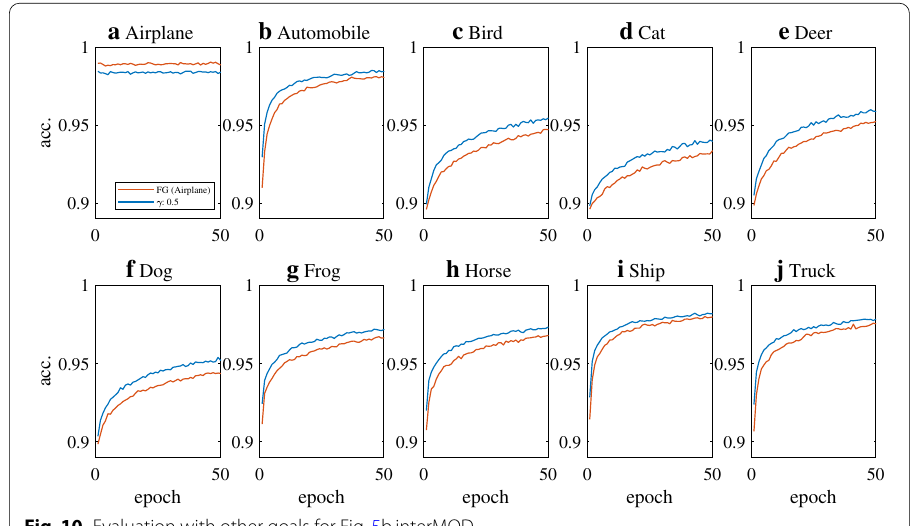
Fig. 10 Evaluation with other goals for Fig. 5b interMOD